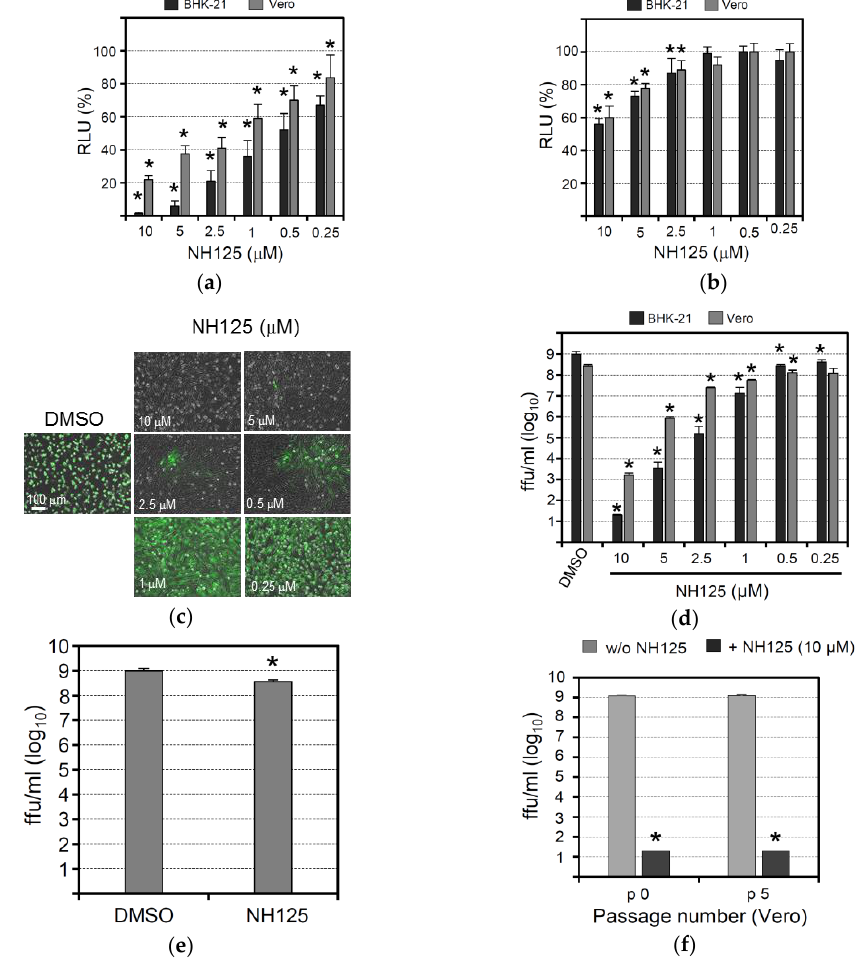
Figure 2. Effect of NH125 on virus-driven luciferase expression and infectious VSV titers. ( a ) Vero and BHK-21 cells were treated for 1 h with NH125 using the indicated concentrations, washed with